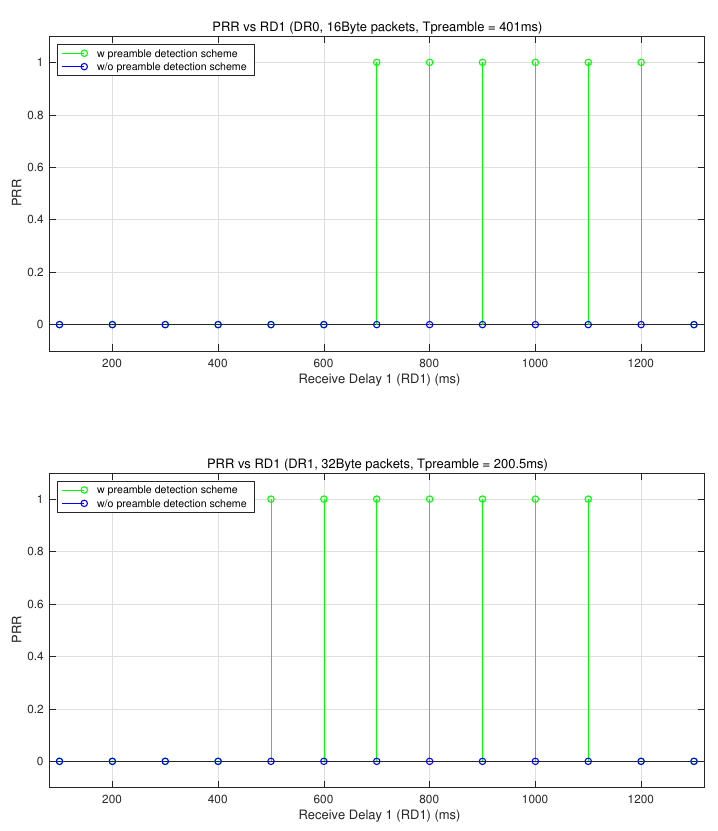
Figure 14. PRR when using the RXW prolonging